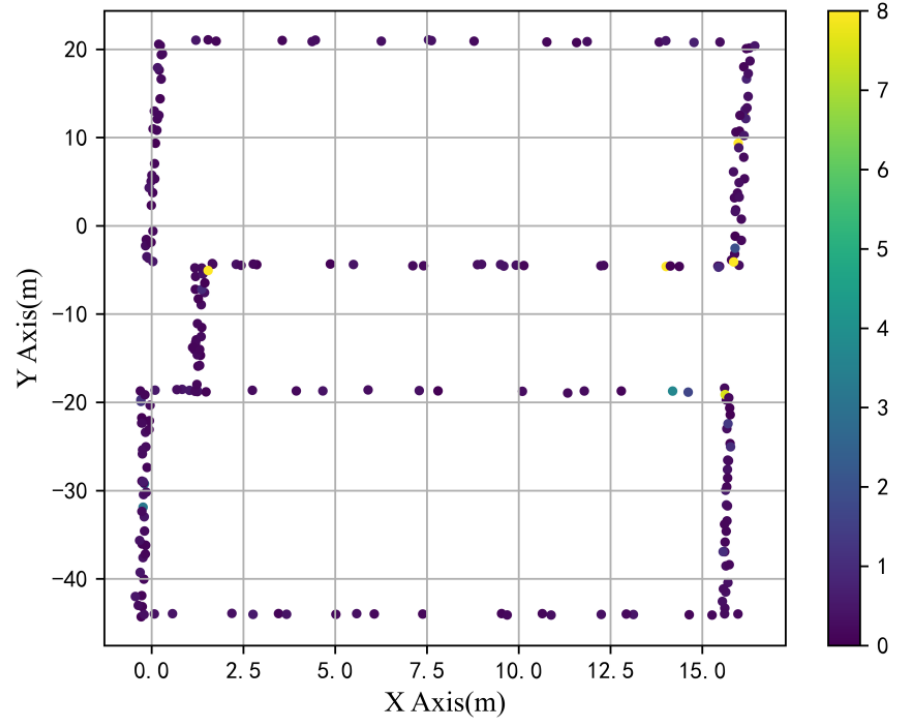
Figure 12. Positioning error heat map of test data on the acquisition path.